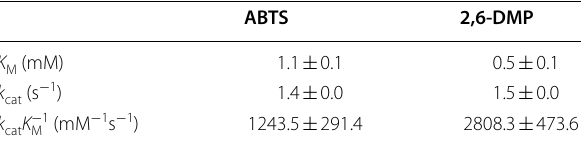
Table 2 Michaelis–Menten kinetic constants of